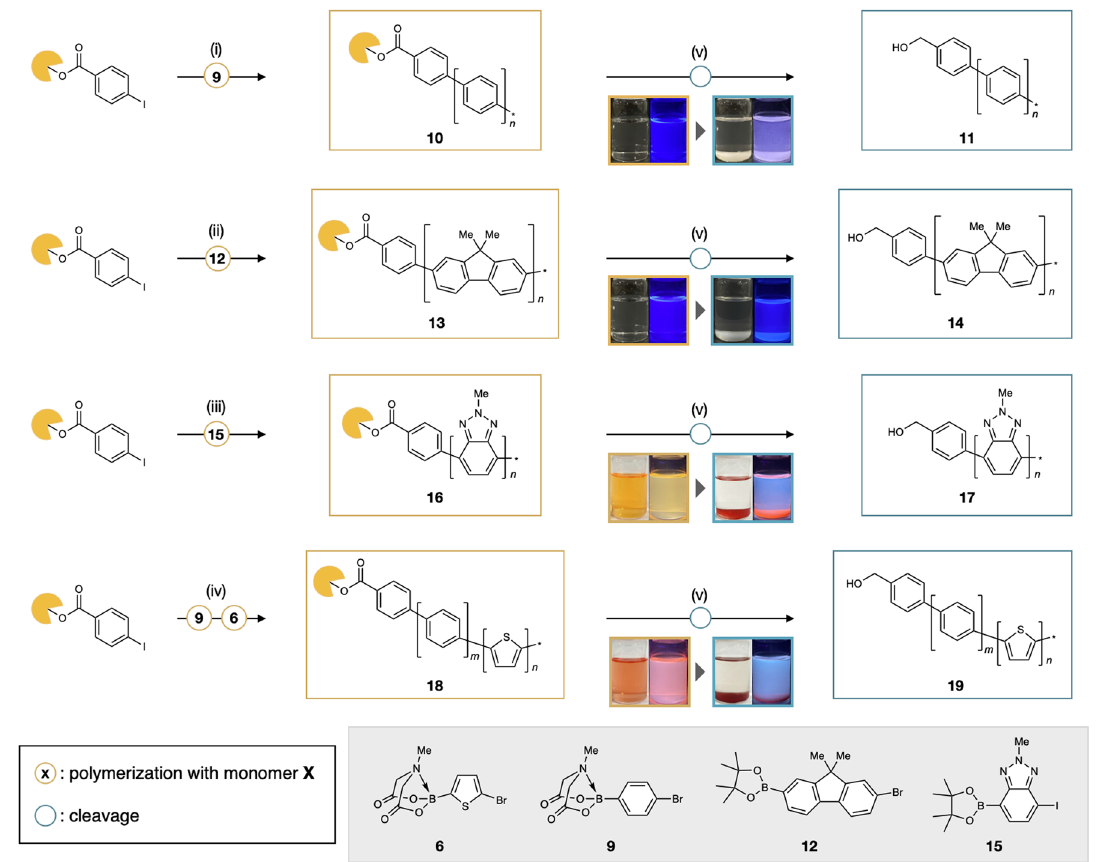
Fig. 4 | Synthesis of dendrimer-ligated and dendrimer-free bare aromatic polymers. Reagents and conditions: (i) RuPhos Pd G3 (1.0 equiv.), RuPhos (1.5 equiv.), K 3 PO 4 (150 equiv.), THF/H 2 O, 50°C, 1h; then 9 (15 equiv.), 50°C, 24h; (ii) t Bu 3 P Pd G2 (1.0 equiv.), 2M Na 2 CO 3 aq. (0.35mL), THF, room temperature, 1h; then 12 (9.0 equiv.), 0°C, 17h; (iii) RuPhos Pd G3 (1.0 equiv.), RuPhos (1.5 equiv.), K 3 PO 4 (150equiv.),THF/H 2 O,50°C,1h;then 15 (10equiv.),40°C,24h;(iv)RuPhos Pd G3 (1.0 equiv.), RuPhos (1.5 equiv.), K 3 PO 4 (150 equiv.), THF/H 2 O, 50°C,